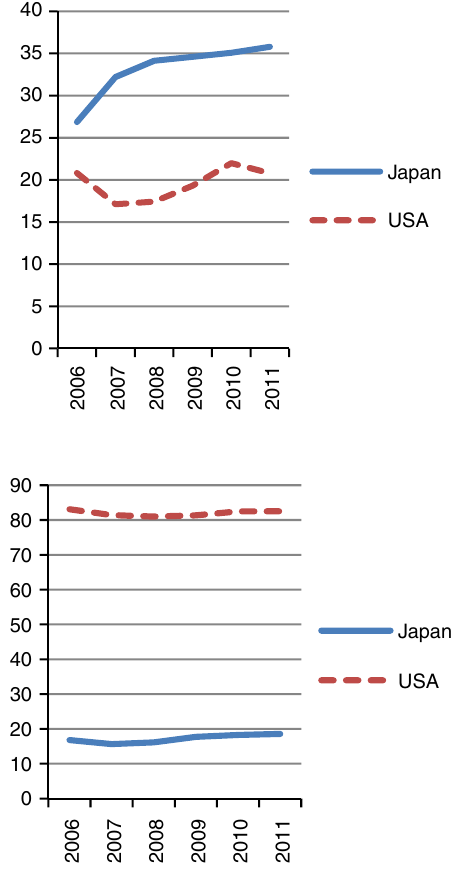
Figure 3. Annual proportion of independent directors on the